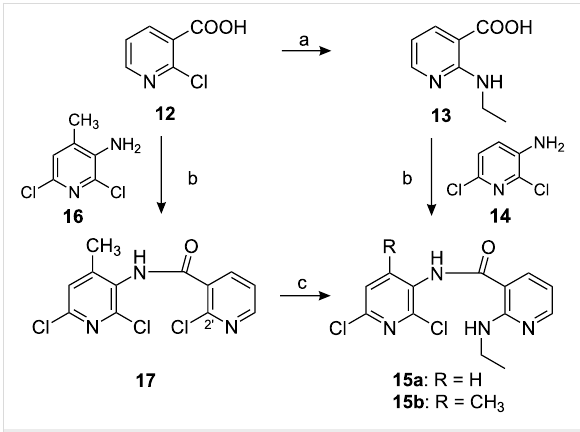
Scheme 1: Reagents and conditions: (a) EtNH 2 , 120 °C, 4 h, 99% (b) i) (COCl) 2 , benzene, DMF, rt, 1 h; ii) amine 14 or 16 , dioxane, cyclo- hexane, pyridine, rt, 16 h, 80% (c) EtNH 2 , dioxane, 100 °C, 20 min, 47%.